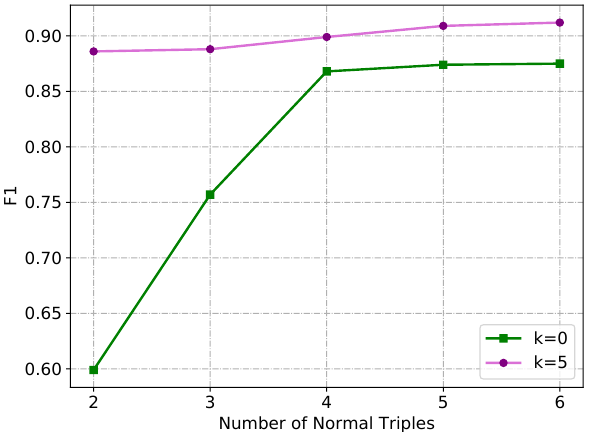
Figure 5. Results on different numbers of implicit triples. The green line indicates not using the triple reasoning module. The purple line indicates there are 5 implicit triples at most in the raw